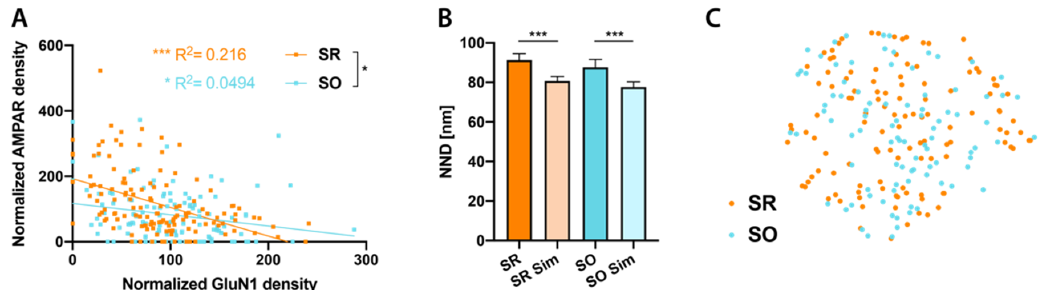
Figure 3. Relationship between AMPAR and N-methyl-D-aspartate (NMDA) receptor (NMDAR) distributions. ( A ): Significant negative correlation between normalized GluN1 and AMPAR particle densities in both SR and SO (SR: R 2 = 0.216, p < 0.0001; SO: R 2 = 0.0494, p = 0.019, linear regression followed by Holm–Sidak multiple comparison correction). Regression line is significantly steeper in SR than SO (F = 5.12, p = 0.021). ( B ): In both SR and SO, NNDs between real AMPAR particles and real GluN1 particles are significantly larger than those between real AMPAR particles and simulated GluN1 particles (SR: p < 0.0001, n = 119 synapses; SO: p = 0.0002, n = 92 synapses), indicating subsynaptic segregation of AMPA and NMDA receptors (paired t -test followed by Holm–Sidak multiple comparison correction). C : t -distributed stochastic neighbor embedding ( t SNE) plot of PSDs with labeling for both AMPAR and GluN1 showing SO and SR synapses. * p < 0.05, *** p < 0.001.